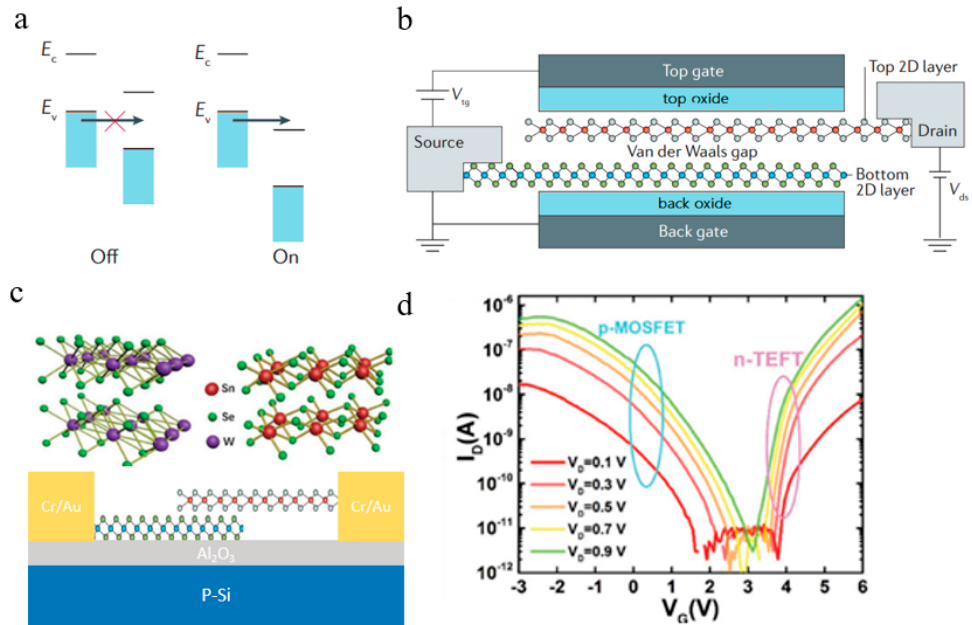
Figure 7. Tunneling field effect transistors structure and transfer curve ( a ) Band offset of p-type semiconductor and n-type semiconductor. ( b ) A schematic illustration of TFETs. The devices consist